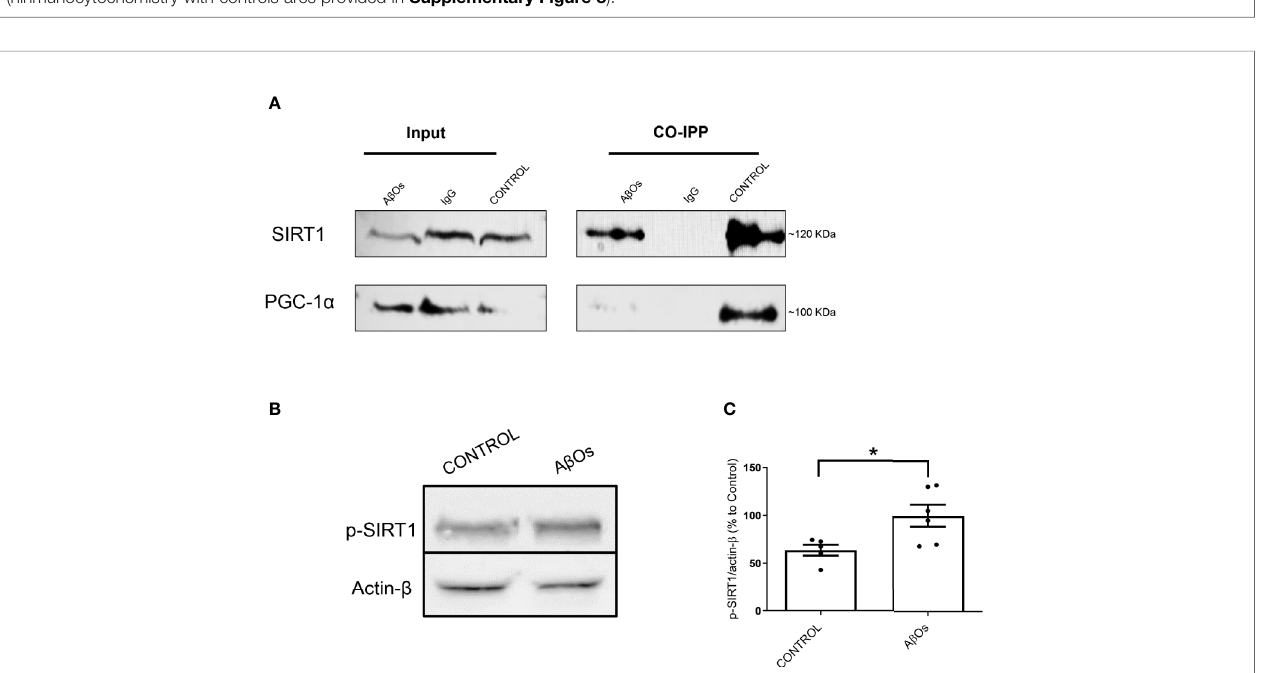
FIGURE 9 | Changes in interaction between the PGC-1 a /SIRT1 and association with the levels of p- SIRT1 after chronic treatment with A b Os. (A) Representative western blot for PGC-1 a (91 kDa) and SIRT1 (120 kDa) in PC-12 cells in control condition (Iane 1) and after chronic treatment with A b Os (0.5 m M; Iane 3). Lane 2 is the IgG control. Co-immunoprecipitation of SIRT1 with PGC-1 a are shown in lanes 4, where we can see untreated cells, lane 5 corresponds a IgG control, and lane 6 corresponds to A b Os treatment (B) western blot of whole cell lysates of PC12 cells treated with A b Os (0.5 m M) for 24 h showing p-SIRT1 levels. (C) Quanti fi cation of p-SIRT1 levels normalized to b actin. Data are represented as mean ± SEM. *p < 0.05, compared between the control group. Student's t-test followed by unpaired t-test was used for all statistical analyses. PGC-1 a , Peroxisome proliferator- activated receptor gamma coactivator 1-alpha; SIRT1, silent information regulator 2 homolog 1 (n=3/group) (Original blots are provided in Supplementary Figure 9